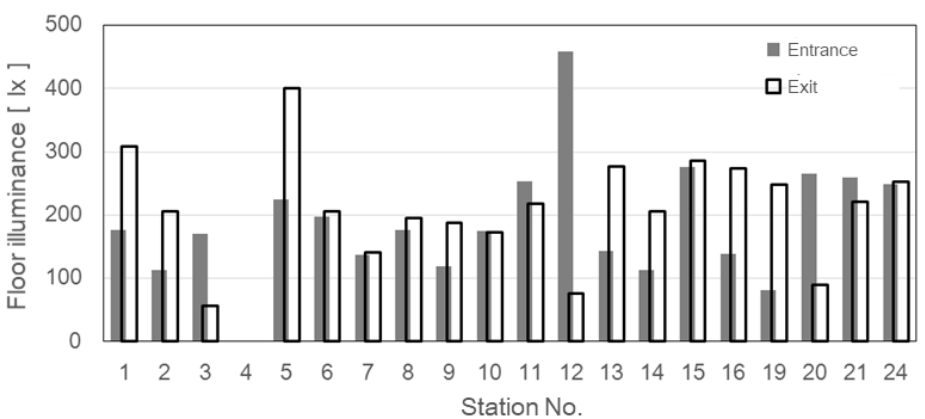
Figure 9. Comparison of floor illuminance measurement results at the entrance and exit of stairs.